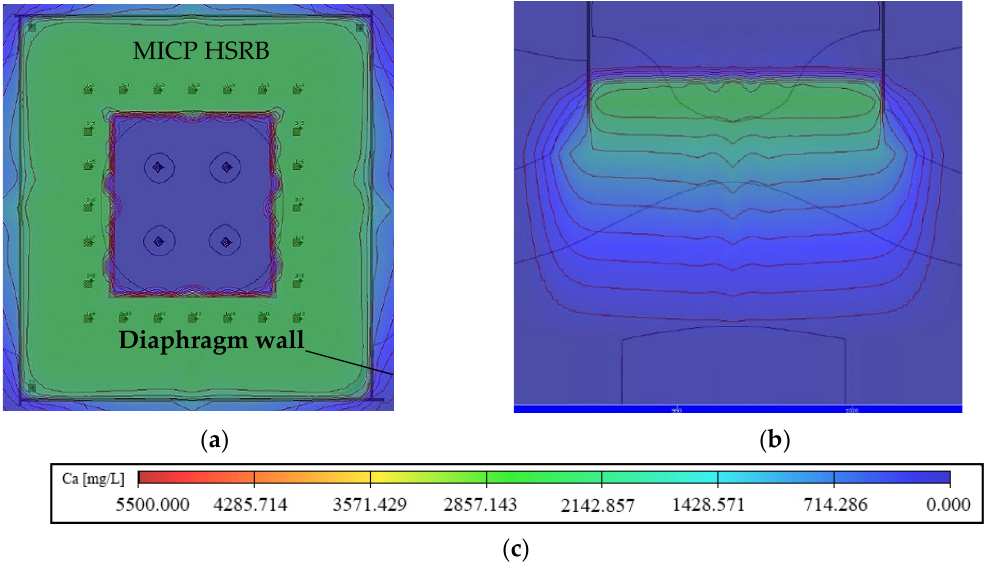
Figure 23. Migration diagram of stationary solution: ( a ) Horizontal; ( b ) Vertical; ( c ) Legend.